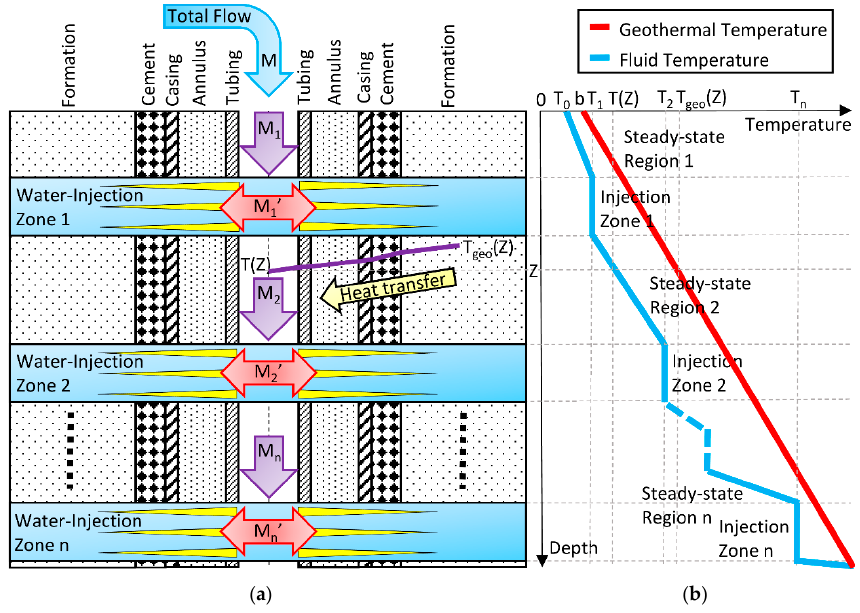
Figure 3. Flow and temperature along a vertical multiple-zone water-injection well. ( a ) Longitudinal section of the well. At center of wellbore, a fluid (water) flows down along the tubing. Due to the difference between fluid and geothermal temperatures, heat transmission occurs from the formation (surround rock) to the fluid across the cement, casing, annulus, and tubing; ( b ) The plot illustrates the qualitative behavior of the fluid and geothermal temperatures along the wellbore.